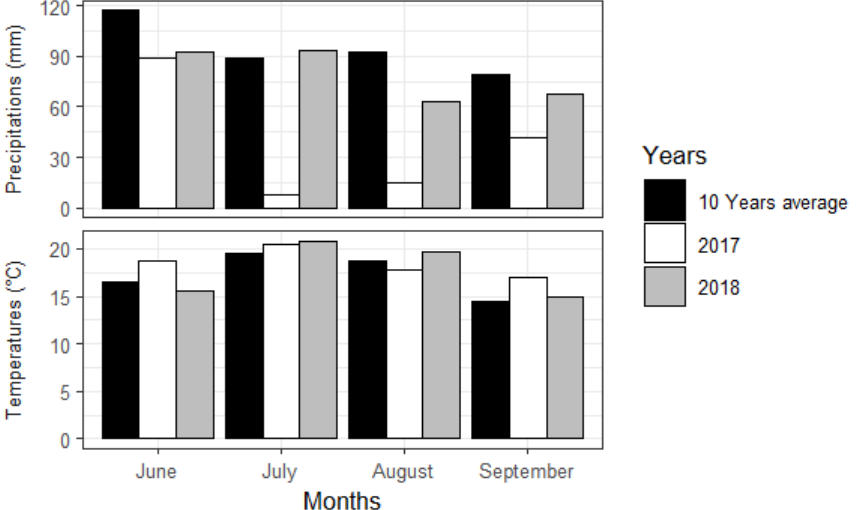
Figure 2. Growing-season months (2017–2018) and 10-year averages of weather data at Lemieux, Quebec (46°09 ′ 56 ′′ N 72°19 ′ 28 ′′ W), near experimental sites [53].